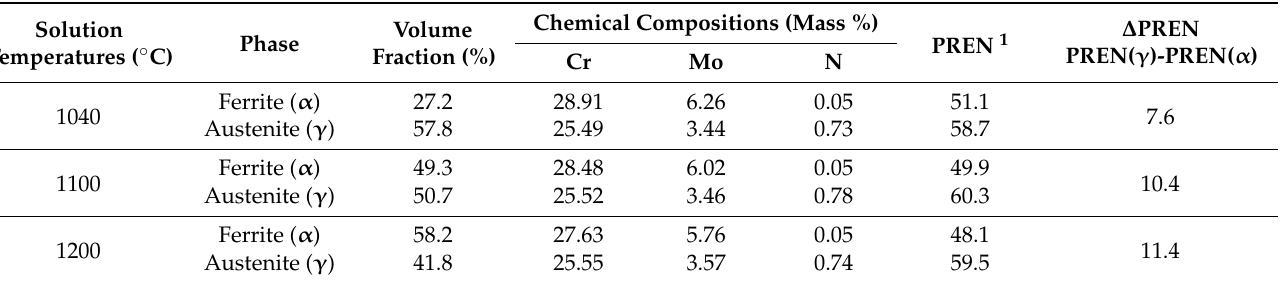
Table 1. Chemical compositions and PREN values of α and γ phases of the specimens at different solution treatment